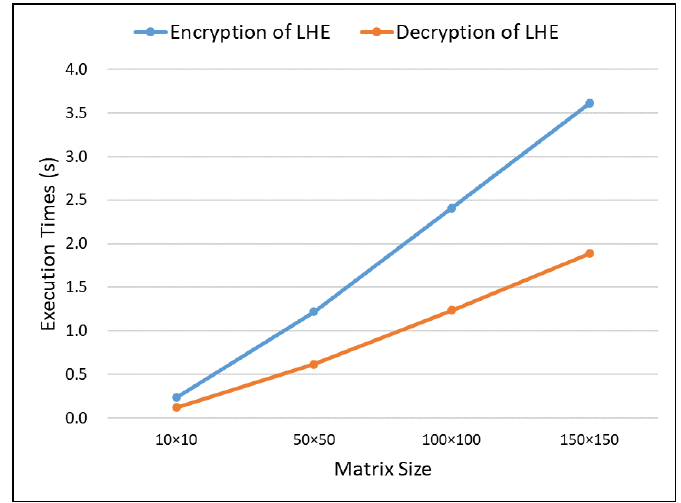
Figure 6. The time cost for the request user.